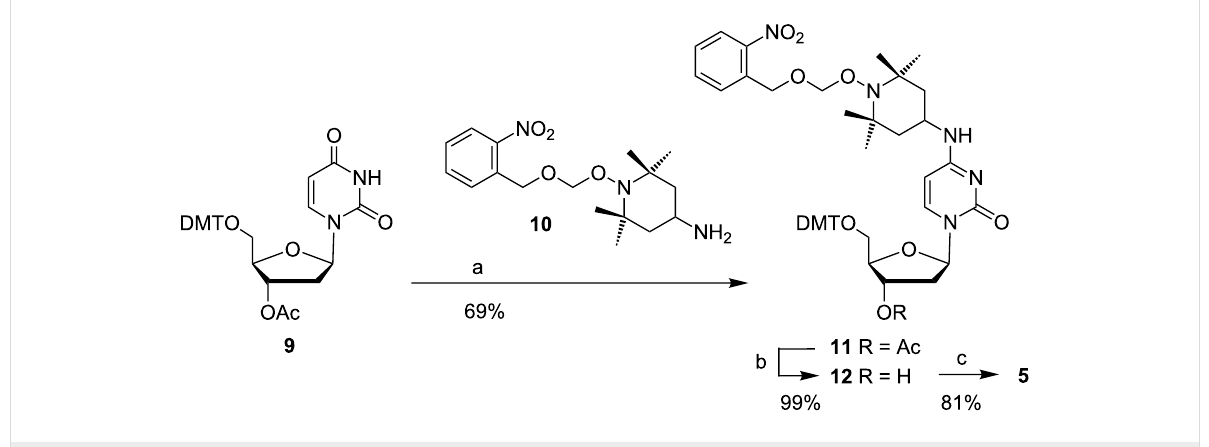
Scheme 1: Synthesis of phosphoramidite 5 . Reagents and conditions: (a) 1. 2,4,6-triisopropylbenzenesulfonyl chloride, Et 3 N, 4-dimethylamino- pyridine, CH 2 Cl 2 , 0 °C → rt, 19 h; 2. addition of 10 , diisopropylethylamine, DMF, 90 °C, 24 h; (b) MeOH, NaHCO 3 , rt, 2.5 h; (c) N , N -diisopropylamino(2-cyanoethyl)phosphoramidic chloride, Et 3 N, CH 2 Cl 2 , rt, 20 h.